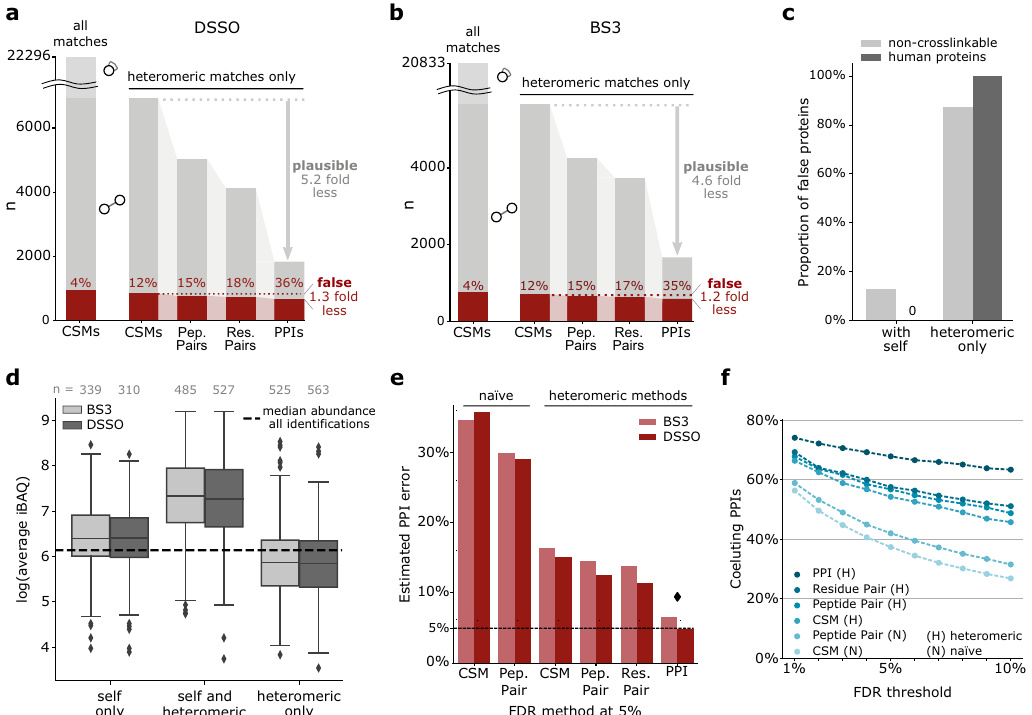
Fig. 2 Comparative analysis of different methods of FDR estimation in crosslinking MS. a , b False identi fi cations as a function of merging heteromeric CSMs passing a naïve decoy-based CSM-FDR of 5% for a DSSO and b BS3, respectively. When merging crosslink data from CSMs to PPIs, the number of identi fi cations decreases and the fraction of false identi fi cations increases. CSMs rarely corroborated each other in false PPIs while plausible PPIs were supported by multiple CSMs. Heteromeric CSMs are indicted by circles connected with a straight line; self-CSMs by a circle with curved line. c Proportion of proteins involved in false PPIs with self-links or with only heteromeric crosslinks, of non-crosslinkable E. coli proteins and the entrapment database. d Proteins found exclusively in heteromeric PPIs had a lower abundance than all identi fi ed proteins and thus a low chance to be detected. Boxplots depict the median (middle line), upper and lower quartiles (boxes), 1.5 times of the interquartile range (whiskers) as well as outliers (single points). e PPI error resulting from a 5% FDR threshold of FDR approaches performed in other studies (Supplementary Table 1). Each bar is from a separate FDR calculation. Diamond denotes the method leading to the PPI error closest to 5%. f Fraction of protein pairs with similar elution pro fi les (correlation coef fi cient > 0.5) among the PPIs passing a given FDR threshold, applying different published FDR methods (Supplementary Table 1). Averages of BS3 and DSSO data are shown (Also presented sepearately in Supplementary Fig. 4). Source data for panels a , b and d are provided as a Source Data fi